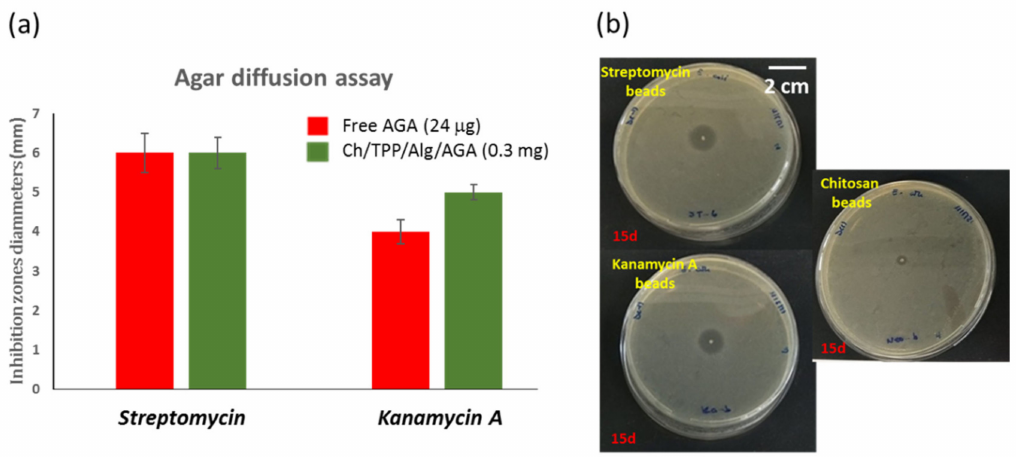
Figure 7. ( a ) Inhibition zone diameters (mm) of the free AGAs (red) and Ch/Alg/TPP/AGA (green) after 24 h. Error bars represent the standard errors. ( b ) Antimicrobial agar-diffusion assay of microspheres after 15 days.